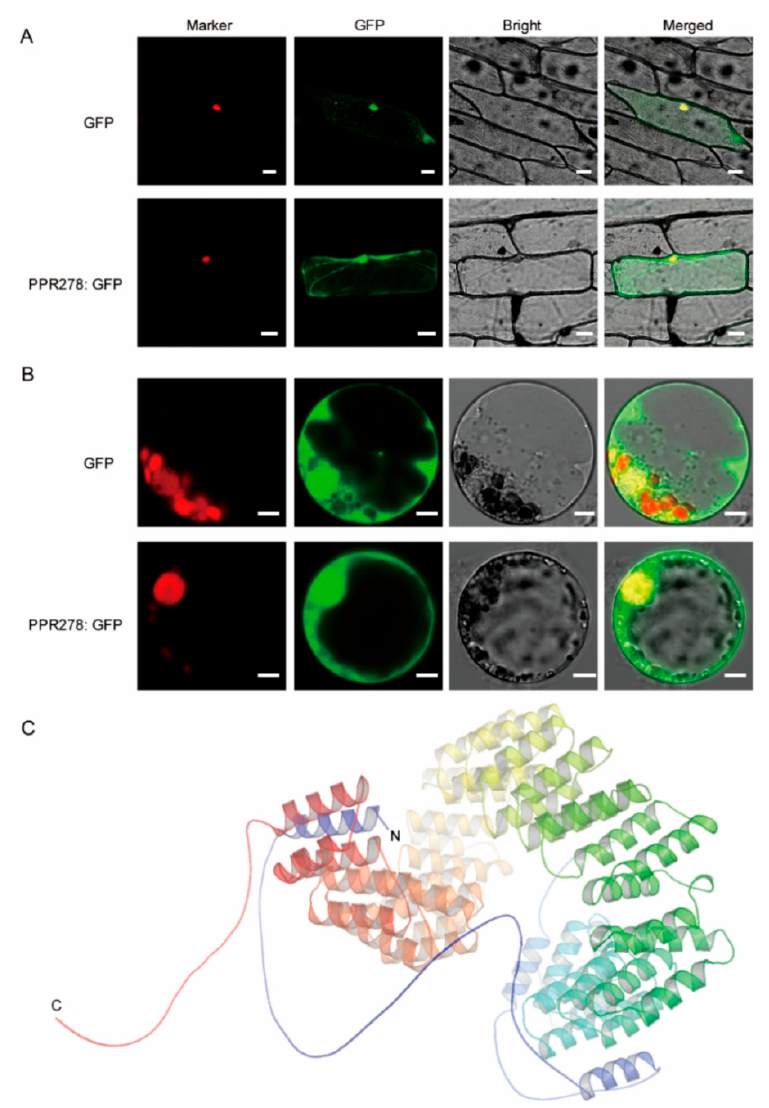
Figure 3. PPR278 was localized to the nucleus and mitochondria and predicted to form a series of alpha helices. ( A , B ) Transient expression of PPR278 in onion epidermal cells ( A ) and maize protoplasts ( B ). GFP was used as a control (top panels of ( A , B )) and was co-expressed with the nuclear marker (bottom panels of ( A , B )). Bar = 50 µ m ( A ) and 5 µ m ( B ). ( C ) Predicted protein structure of PPR278. The purple and red helices indicate the N terminus (N) and C terminus (C) of PPR278, respectively. 2.4. PPR278 Is Essential for the Cis-Splicing of nad2 Intron 4 and nad5 Introns 1 and